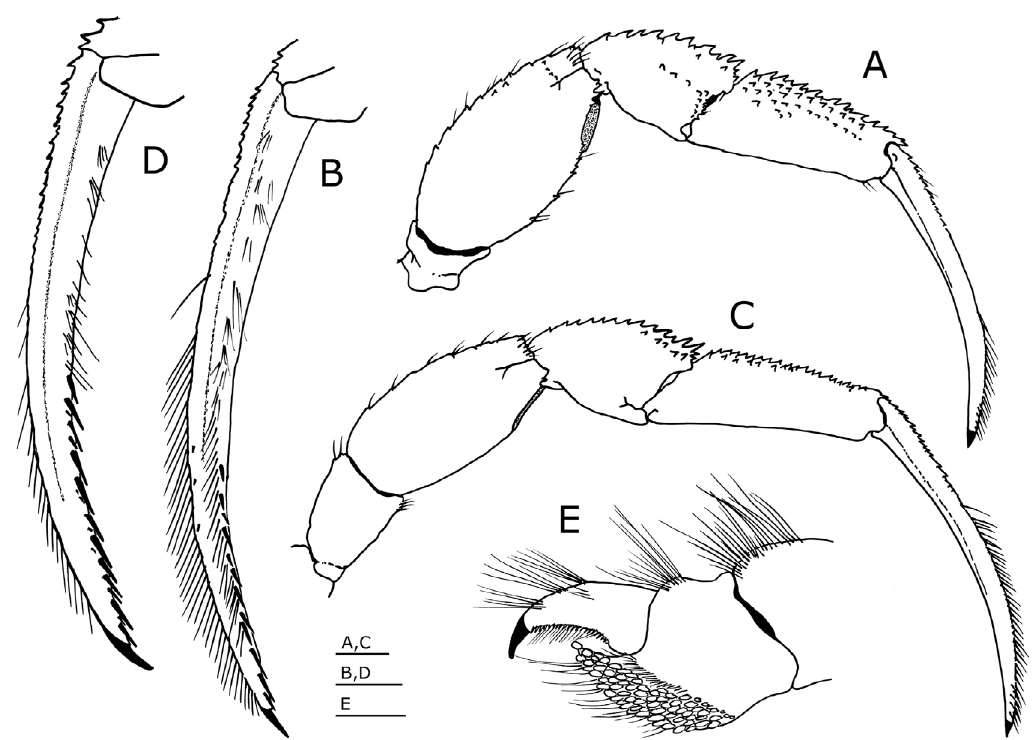
Figure 6. Pagurus smithi (Benedict, 1892), lectotype male 7.9 mm, northeastern Pacific, southern Gulf of California, Mexico, USFC Albatross, sta 2823 (USNM 16716): A , right second pereopod, lateral view; B , dactyl of same, mesial view; C , right third pereopod, lateral view; D , dactyl of same, mesial view; E , propodus and dactyl of left fourth pereopods, lateral view. Scales = 3 mm (A, C), 2 mm (B, D), and 1 mm